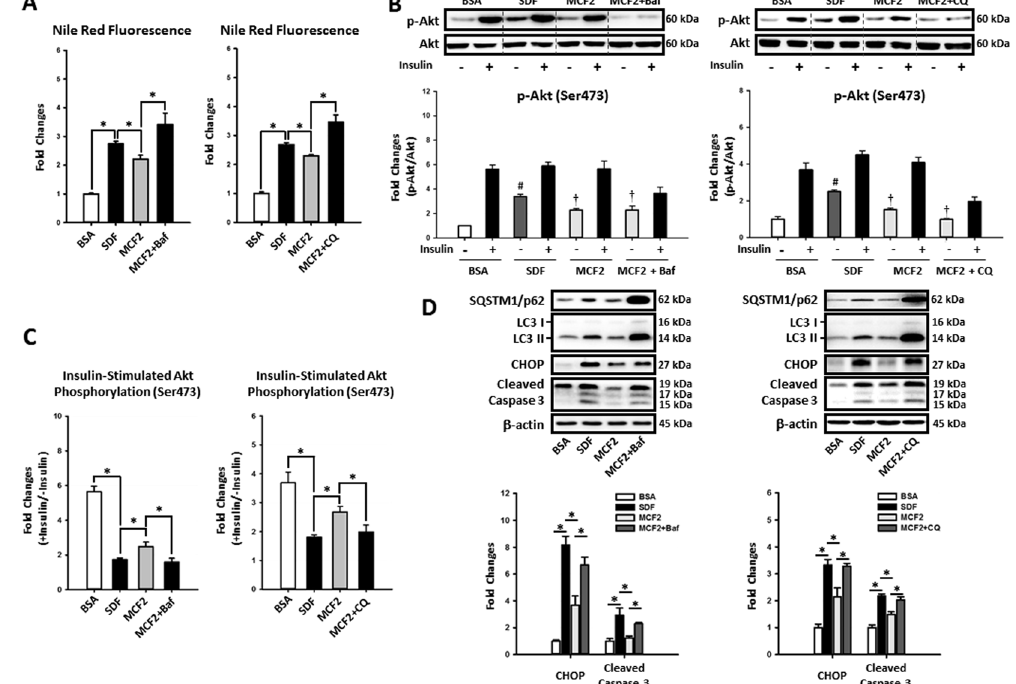
Figure 4. Increasing MCFA ratio protected HepG2 cells against LCFAs-induced fat accumulation, insulin resistance, and lipotoxicity by rescuing autophagy. To investigate the role of autophagy in MCFA-mediated protections, we blocked autophagy in MCF2-loaded HepG2 cells using either Bafilomycin A1 (5 nM) or chloroquine (10 μ M). After treatment, fat accumulation ( A ), insulin resistance ( B and C ), ER stress, and apoptosis ( D ) were analyzed. Values are mean ± SEM (n = 3). For densitometric analyses of Western blotting data, β -actin or total Akt (for Akt phosphorylation analyses only) were used as the loading controls. * , # (vs. BSA treated cells without insulin stimulation), and † (vs. SDF treated cells without insulin stimulation) indicate statistical significance, P < 0.05. n.s.: no significant difference. SDF: standard fat loading mixture (0.4 mM PA + 0.4 mM OA); MCF2: MCFA-containing fat mixture 2 (0.4 mM PA + 0.2 mM OA + 0.2 mM LA); Baf: Bafilomycin A1. CQ: chloroquine. Full-length blots are presented in Supplementary Figure